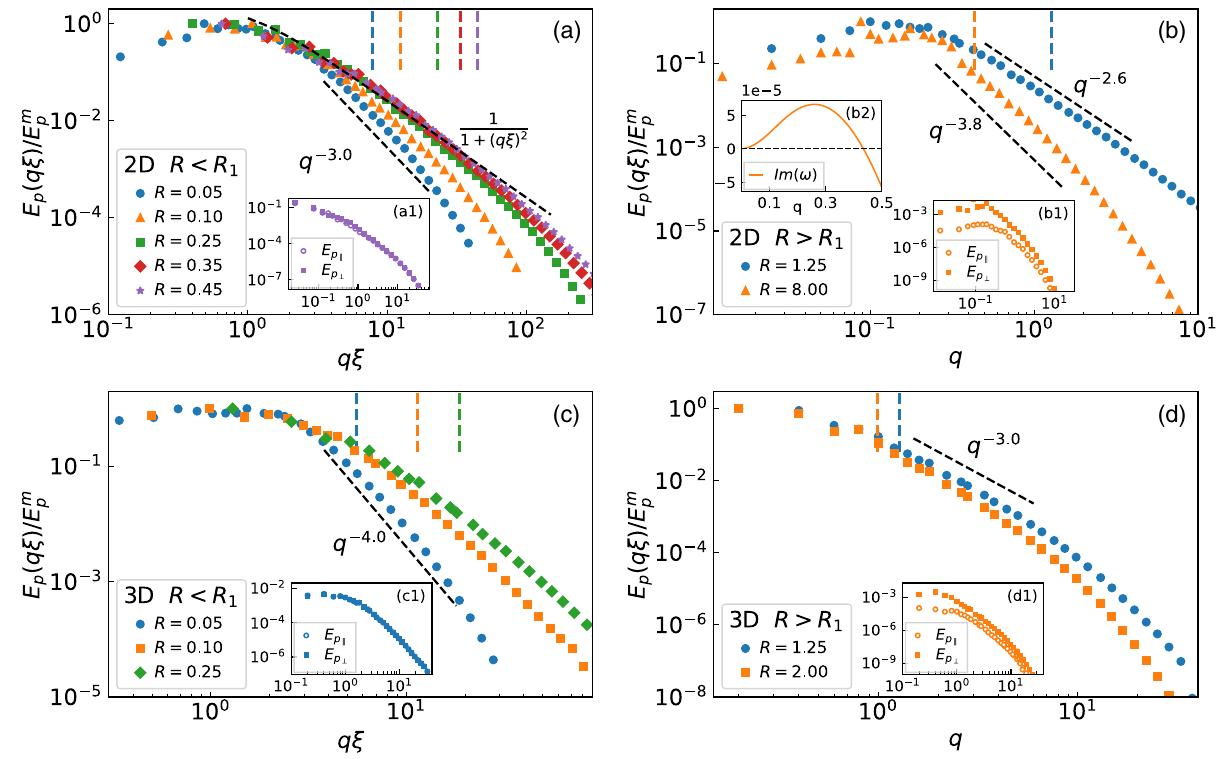
FIG. 6. Order parameter energy spectrum E p ð q Þ for different values of R for (a),(b) two-dimensional [runs SPP4, SPP6, SPP9, and SPP10] and (c),(d) three-dimensional [run SPP3] active suspension. For R < R 1 and q ξ > 1 , we observe a Porod ’ s tail due to defects, i.e., E p ð q Þ ∼ q − 3 in 2D and E p ð q Þ ∼ q − 4 in 3D. As R approaches R 1 , we find E p ð q Þ ∼ 1 = ½ 1 þ ð q ξ Þ 2 (cid:2) consistent with the exponential decay of the correlation function. For R 1 < R < R 2 , E p ð q Þ ∼ q − 2 . 6 for R ¼ 1 . 25 , and the slope increases to q − 3 . 8 for R ¼ 8 . For different values of R , dashed vertical lines (with the same color as markers) indicate the largest q which is linearly unstable. Insets (a1), (b1), (c1), and (d1) show the spectra E p for components of p along the mean ordering direction and E p for a representative direction orthogonal k ⊥ ≈ 10 2 E to it. For R < R 1 , fluctuations are isotropic, whereas for R > R 1 , transverse fluctuations dominate, with E p p k . Note that, ⊥ although the mean order parameter is, of course, consistent with zero for R < R 1 , we use the numerically measured mean ordering direction to define jj and ⊥ . Inset (b2) shows the growth rate for R ¼ 8 . Note that only a small number of modes between q ¼ 0 and q ¼ 0 . 5 are linearly